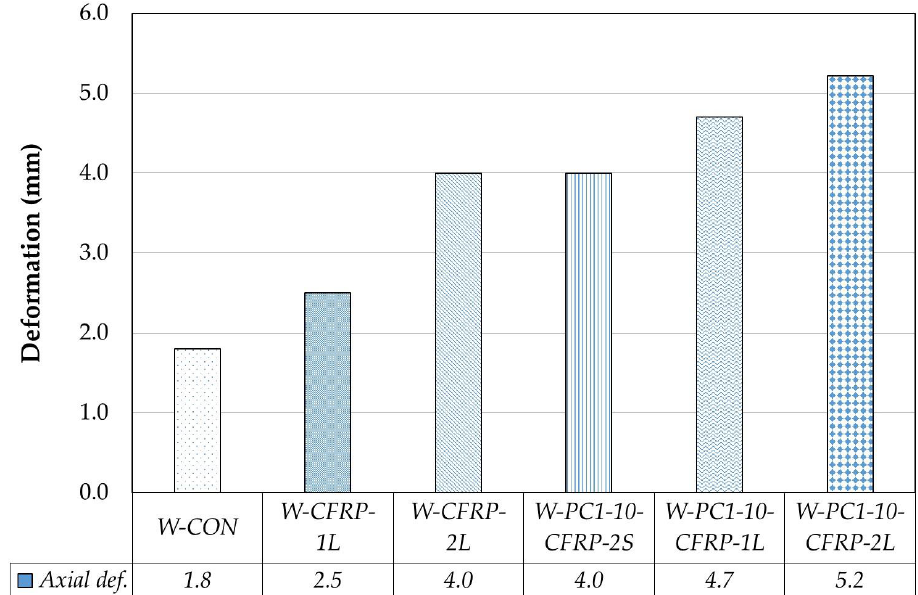
Figure 11. Comparison of ultimate axial deformation of CCI brick walls.